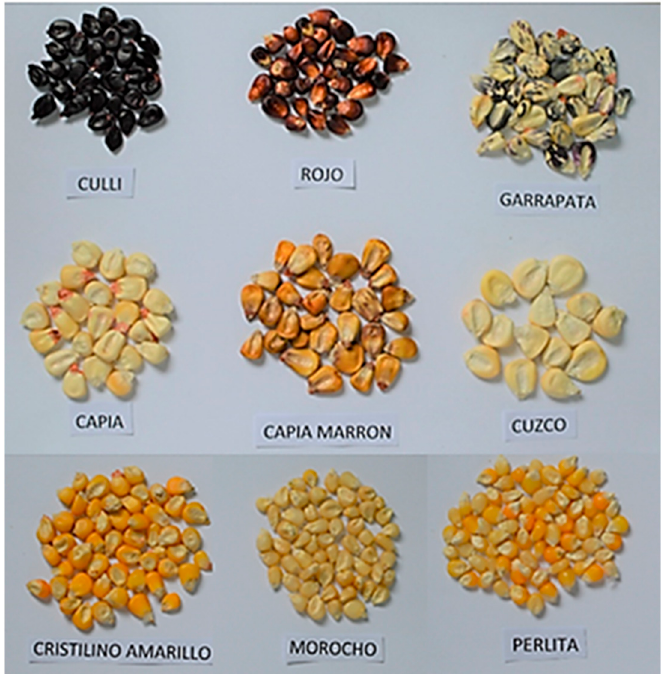
Figure 1. Races identified during the